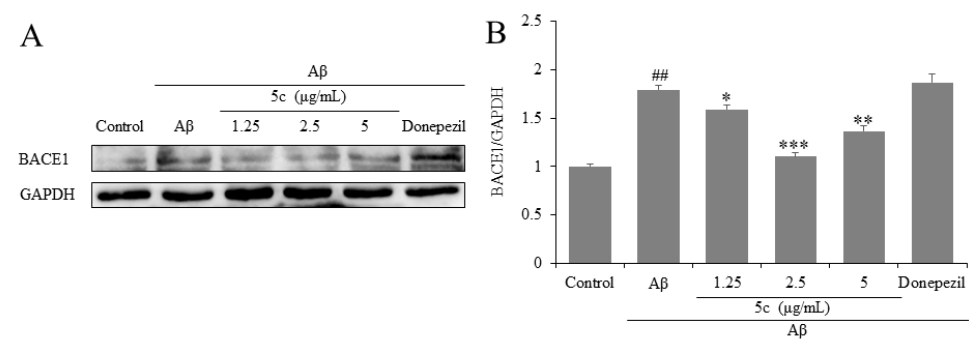
Figure 6. Effects on β -site amyloid precursor protein (APP)-cleaving enzyme 1 (BACE1) of compound 5c in PC12 cells induced by A β 25-35 . ( A ) The protein levels of BACE1 were detected by Western blotting. ( B ) Quantification of BACE1 expression is presented in bar graphs. ## p < 0.01 vs. control group; * p < 0.05, ** p < 0.01, *** p < 0.001 vs. model